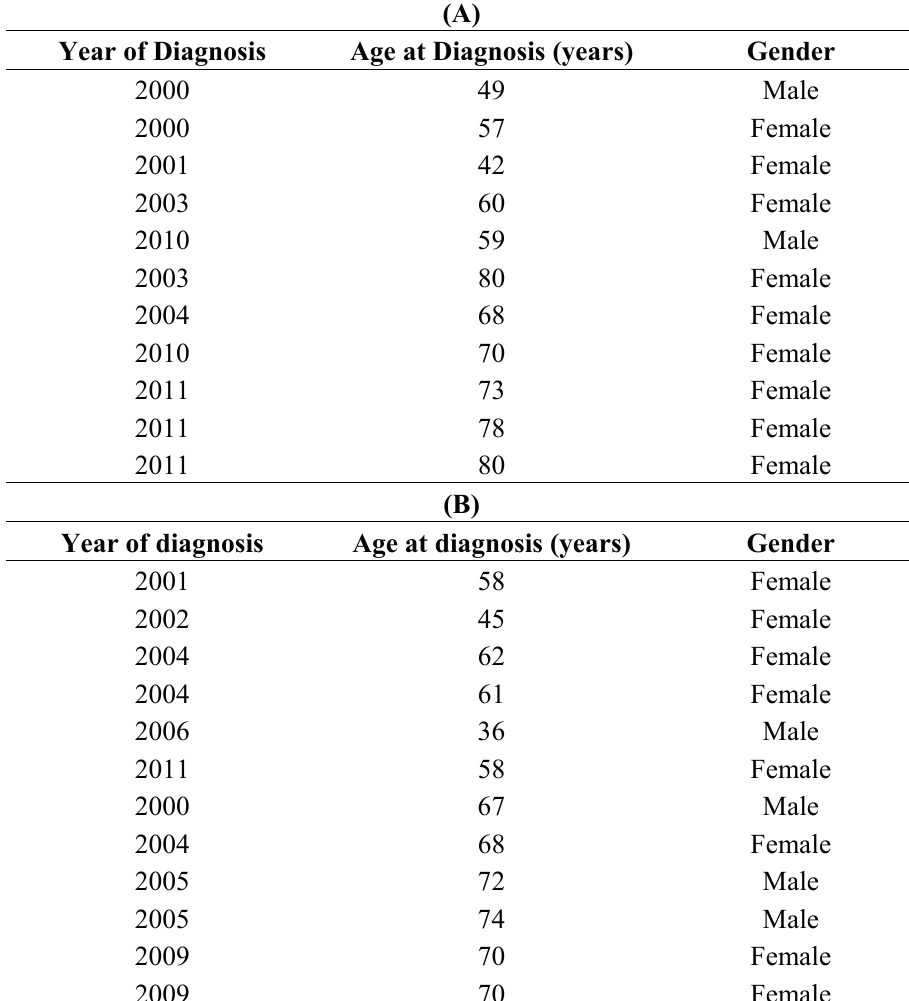
Table 2. Cirrhotic patients of primary biliary cirrhosis and autoimmune hepatitis in the present study. ( A ) Patients with Scheuer stage 4 of primary biliary cirrhosis; ( B ) Cirrhotic patients with autoimmune